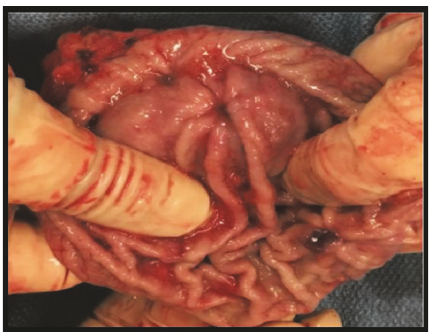
Figure 2: Subtotal gastrectomy distal lesion measuring 0.7cm x 0.7 cm x 0.5 cm. The lesion was found to be malignant melanoma of the stomach that is invasive into the submucosa. No lymphovascular invasion was identified. Six negative lymph nodes appreciated with the